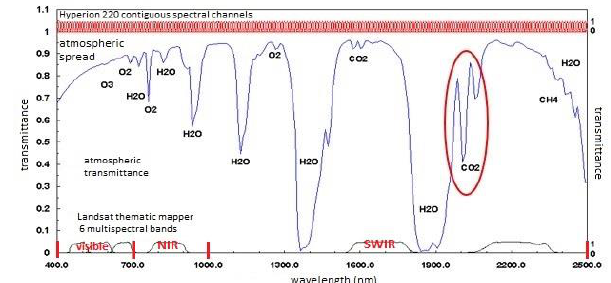
Image 3. Comparison between gas transmittance spectra, highlighting atmospheric carbon dioxide. Adapted from